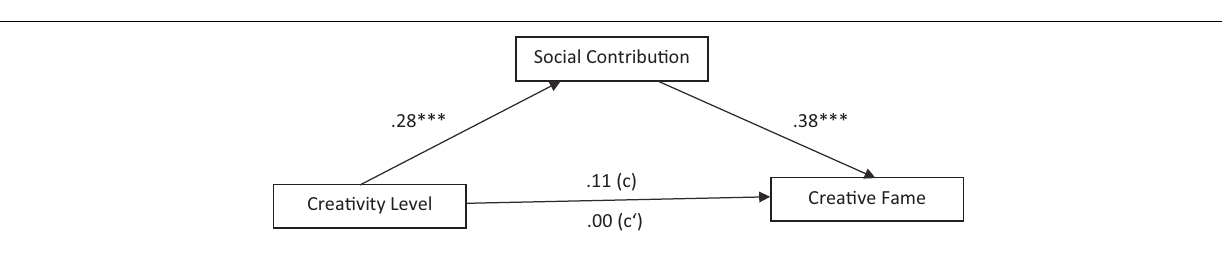
of creativity on creative fame via SC is also not significant but with a lower c’ of 0.00, p = 0.98. A bias-based bootstrap CI for the indirect effect of creativity on creative fame via SC is significant, ab = 0.11, 95% IC (0.05, 0.18). The ratio of the indirect effect to the total effect is